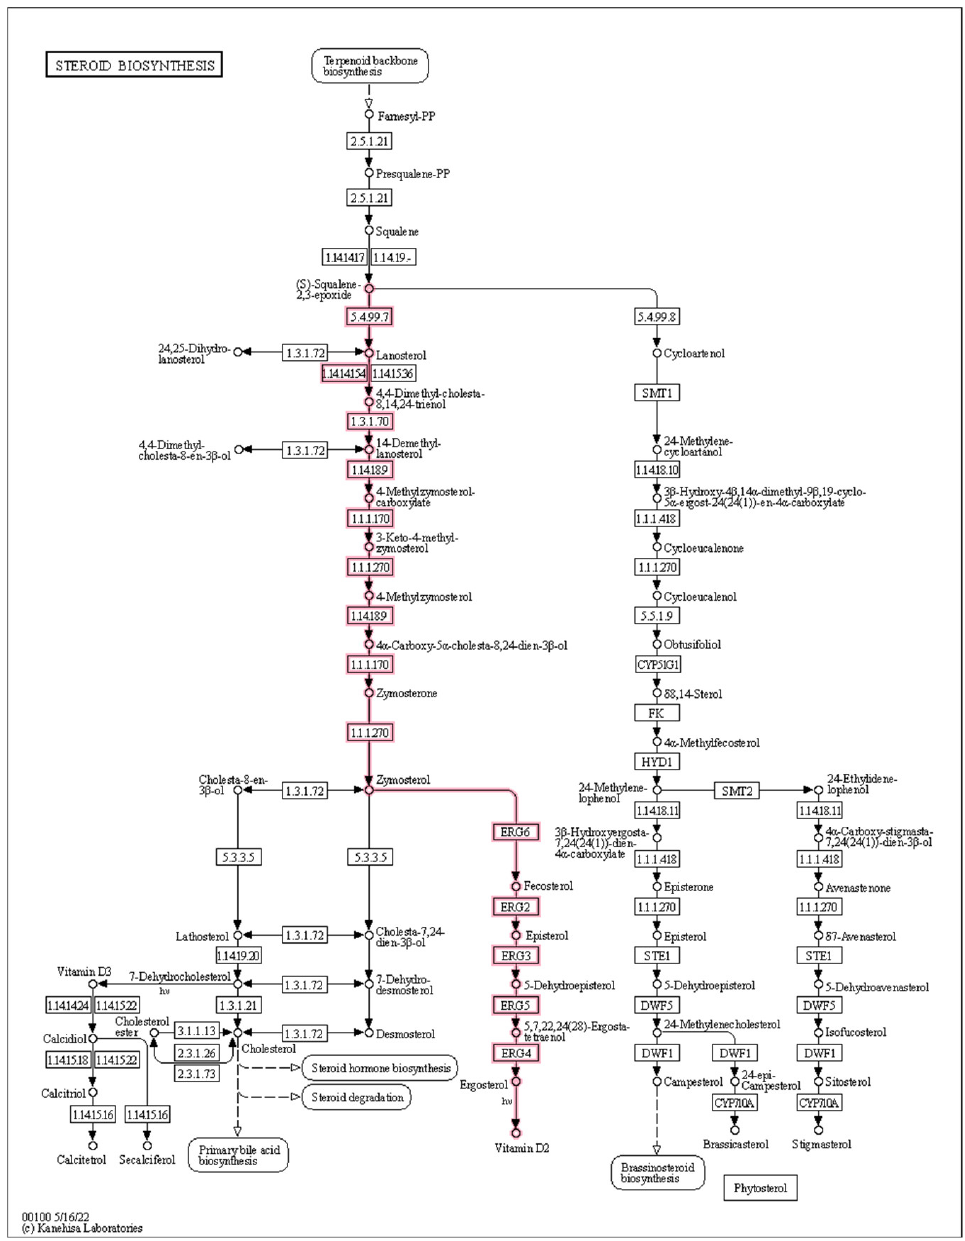
Figure 9. Analysis of DEGs related to steroid biosynthesis. The red highlights indicate higher expression (log 2 FC > 1) in treated group (TG).